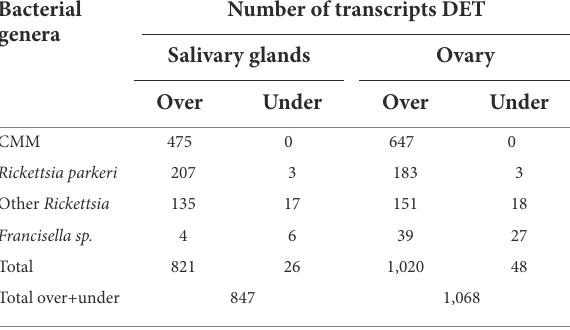
Over Under Over